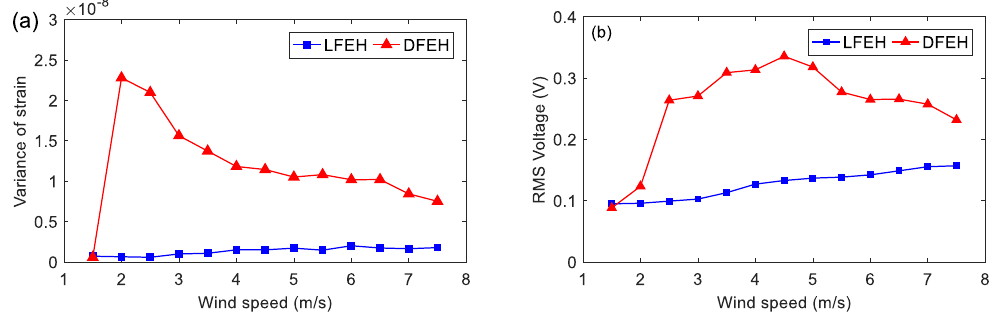
Figure 7. ( a ) Variance of dynamic strain and ( b ) root-mean-square (RMS) voltage versus wind speed (LFEH and DFEH).